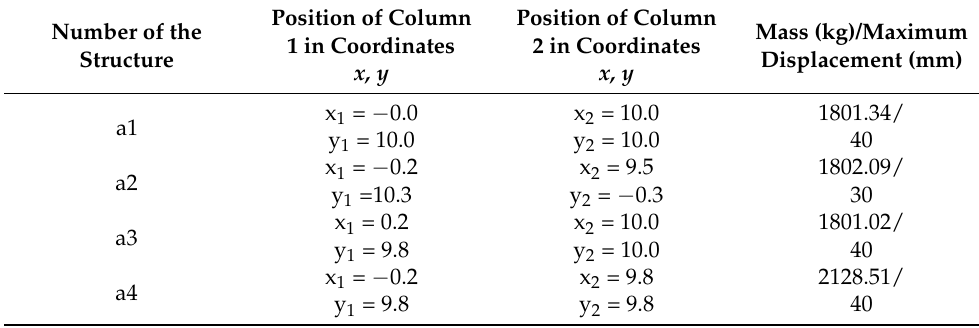
Table 3. The simulation results for the cylindroid structure with a grid pattern of type a (the grid split along shorter diagonals).